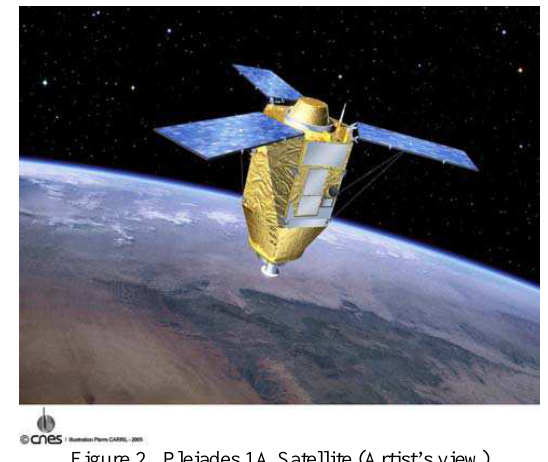
Figure 2. Pleiades 1A Satellite (Artist’s view)